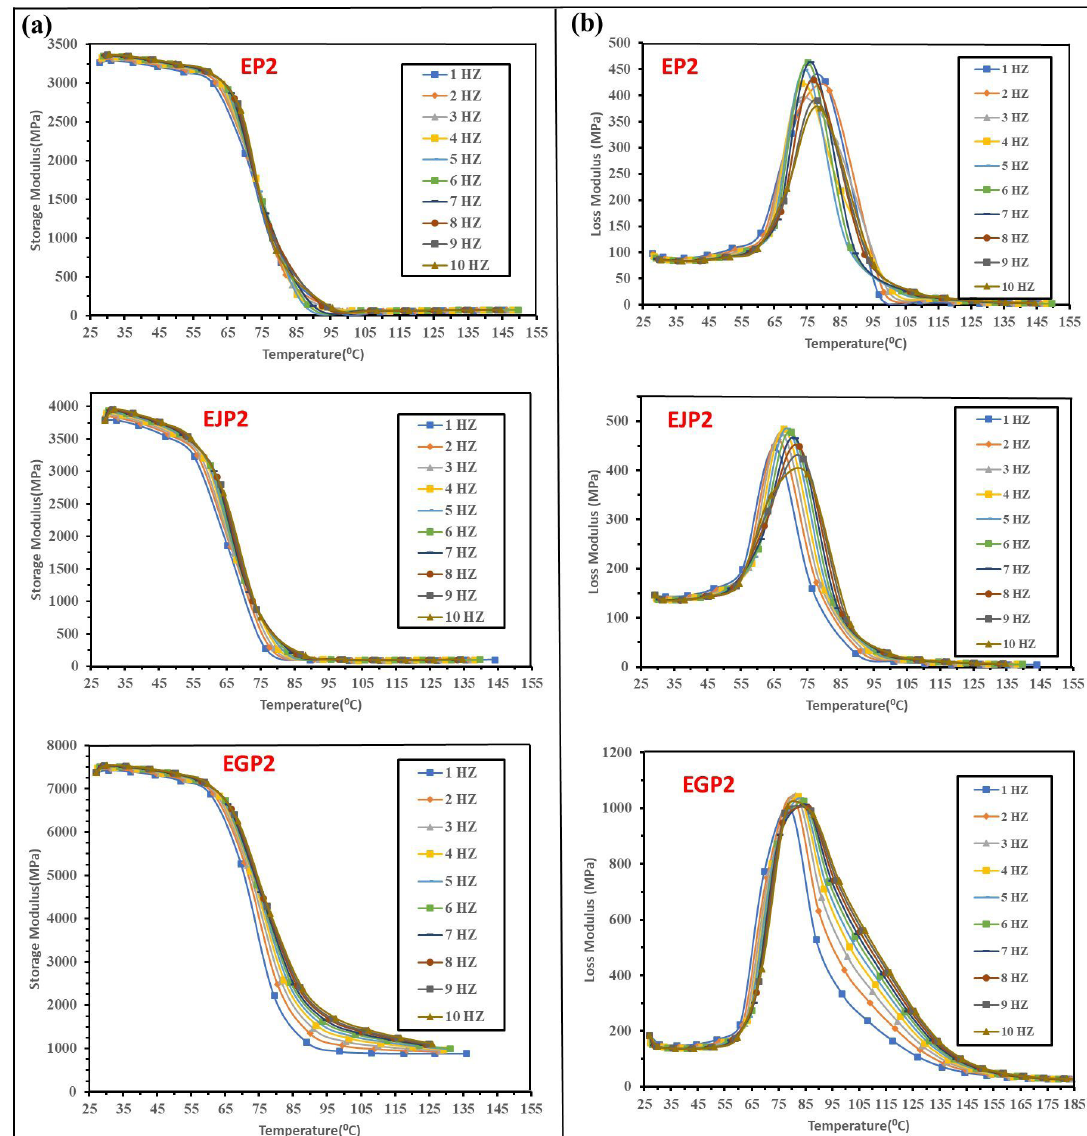
Figure 5. DMA characteristics of EP2 composite, EJP2, and EGP2 hybrid composites: (a) Storage modulus, (b) Loss